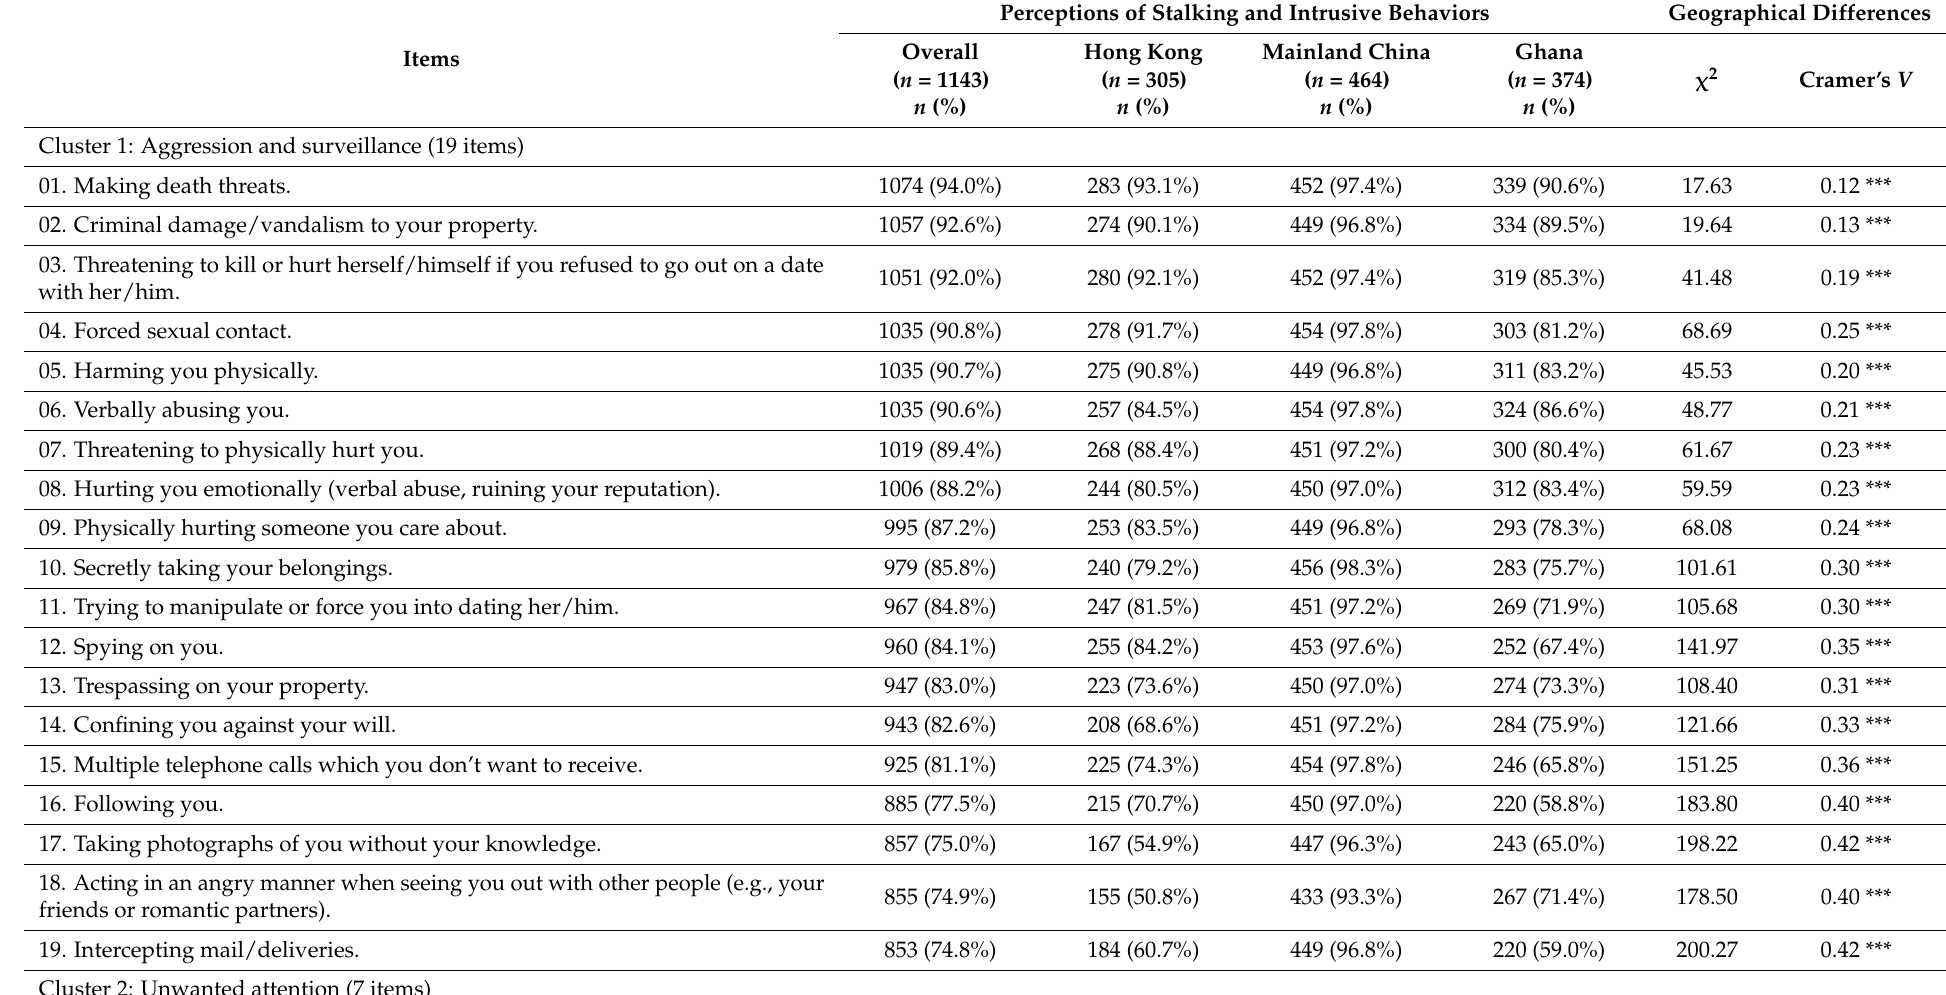
Table 1. Geographical distribution of perceptions of stalking and intrusive behaviors ( n = 1143).